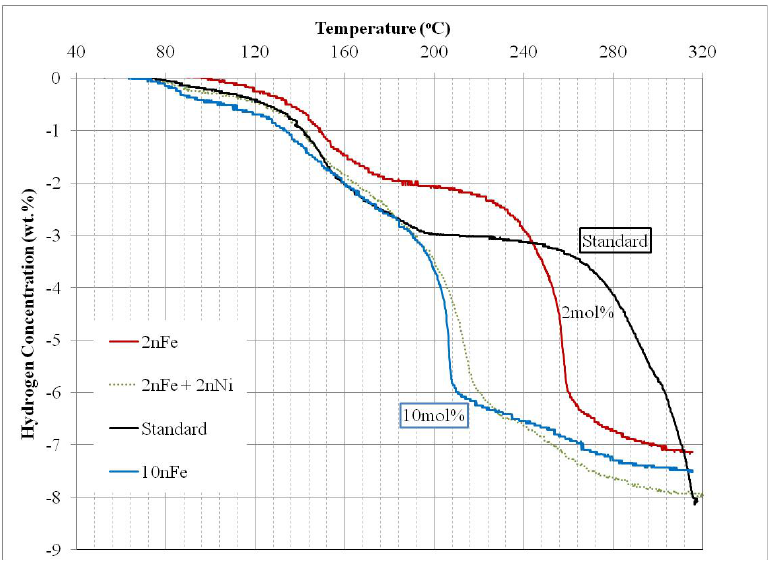
Figure 7. Ramping desorption kinetics comparing LiBNH + n MgH 2 mol% and 10 mol% nano